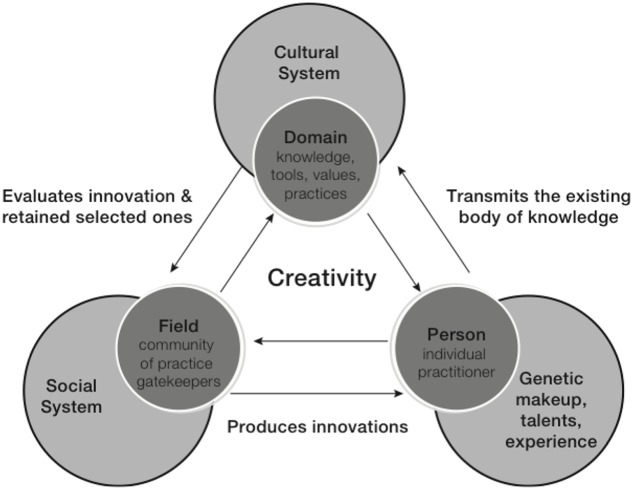
Systems model of creativity (Csikszentmihalyi, 1999, p. 315).